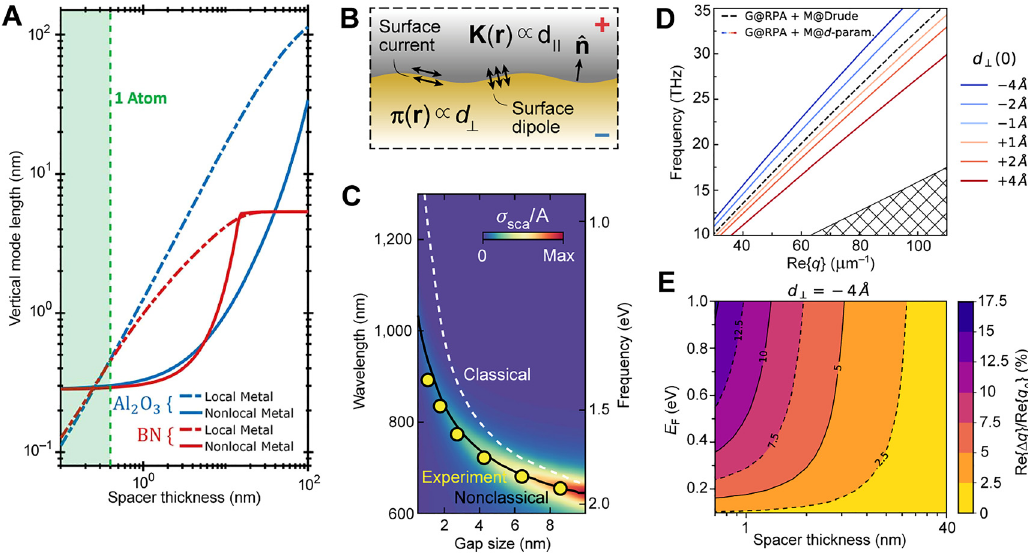
Figure 10: Probing nonclassical response of metals. (A) Vertical field confinement for both Al 2 O 3 and hBN as a function of the spacer thickness for local (dash-dotted lines) and nonlocal (solid lines) metalpermittivity. Adapted with permissionfrom [32].Copyright 2018, AAAS. (B) Nonclassical corrections can be formulated as surface polarizations:theeffectivesurfacedipoledensity π (r) andthecurrentdensity K(r) .(C)Observationoflargenonclassicalcorrections.(B)and(C) Adaptedwithpermissionfrom[67].Copyright2019,SpringerNature.(D)Impactof d ⊥ ontheIGPdispersion.(E)Relativetheoreticallypredicted shift of the IGP wavevector with and without applying the d ⊥ -parameter correction for different graphene doping levels E F and spacer thicknesses d . (D) and (E) Adapted with permission from [36]. Licensed under a Creative Commons